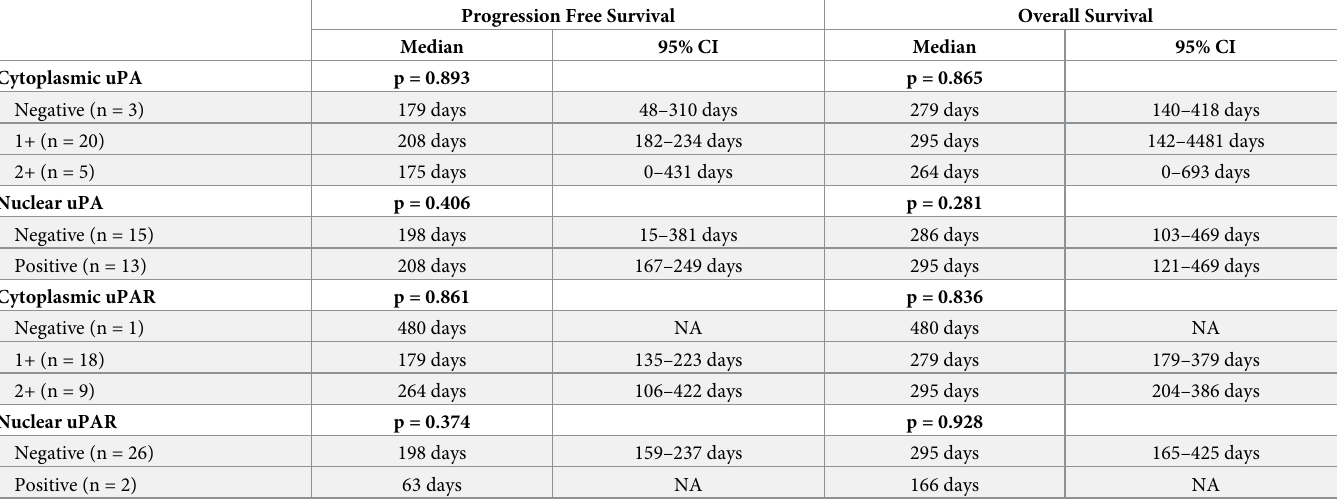
Table 6. Survival times of 28 osteosarcoma-bearing dogs with different uPA and uPAR tumor expression.